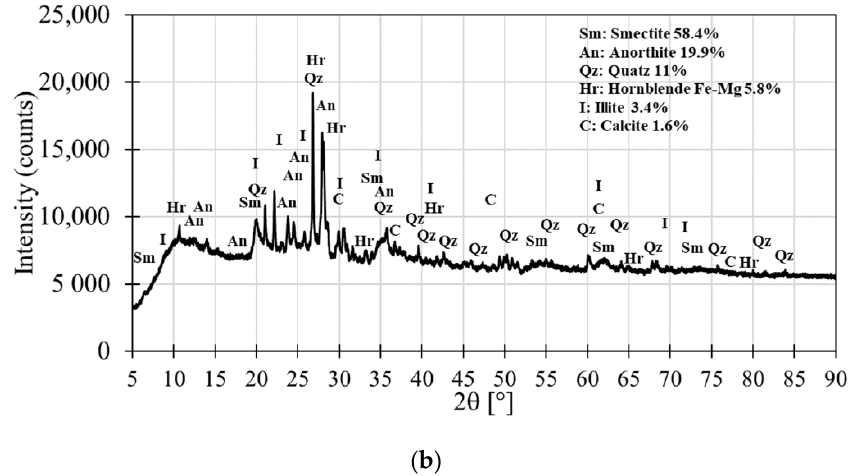
Figure 6. Chemical and mineralogical composition of Lampa clay: ( a ) EDX results; ( b ) XRD analysis (R wp = 2.8 GoF = 2.3).